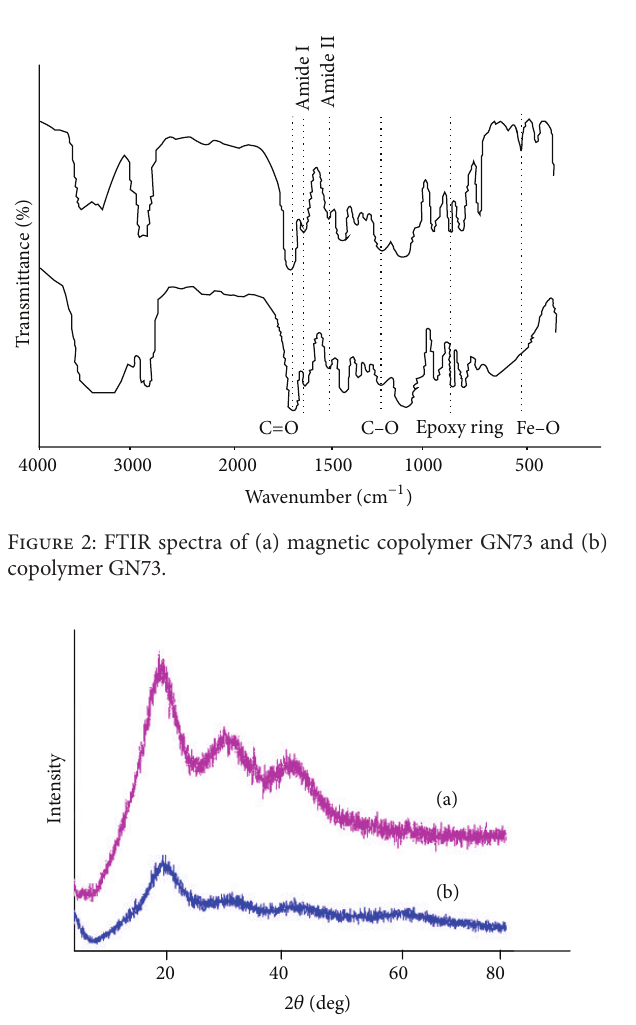
Figure 3: Comparison of peaks in X-ray diffraction for (a) magnetic copolymer GN73 and (b) copolymer GN73.